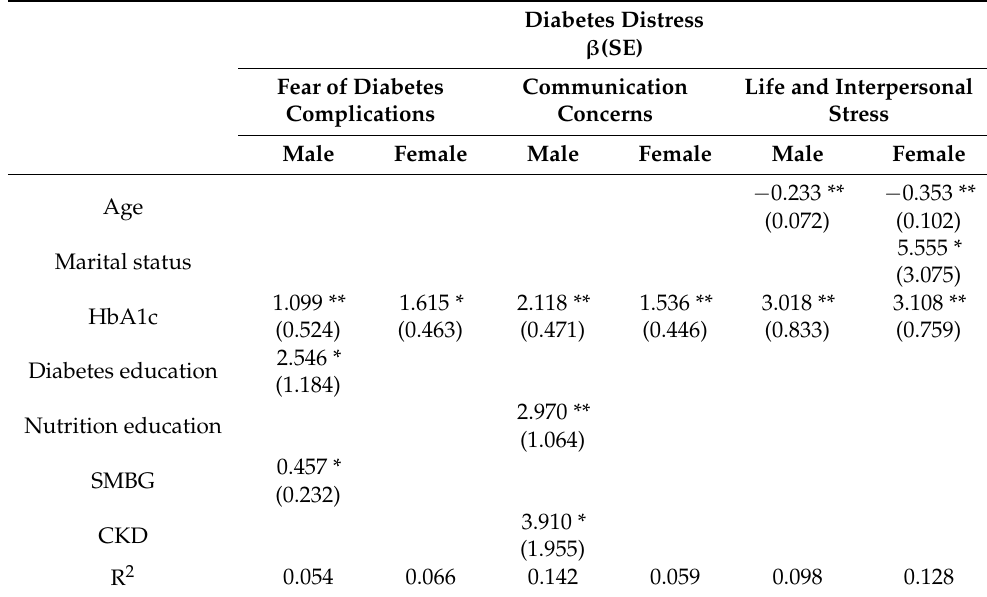
Table 3. Regression analysis of diabetes distress